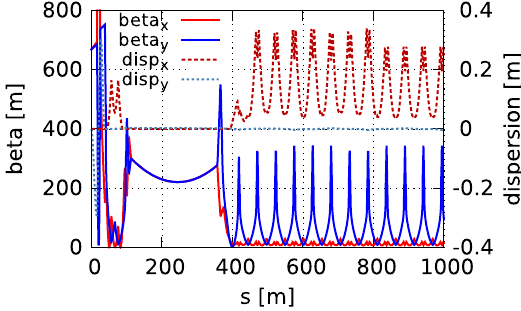
FIG. 8. Beta functions and dispersion at the beginning of arc4 with the detector bypass included. It features the vertical spreader, the initial horizontal bending, the straight section, the modified dispersion suppressor, seven junction cells, and four regular